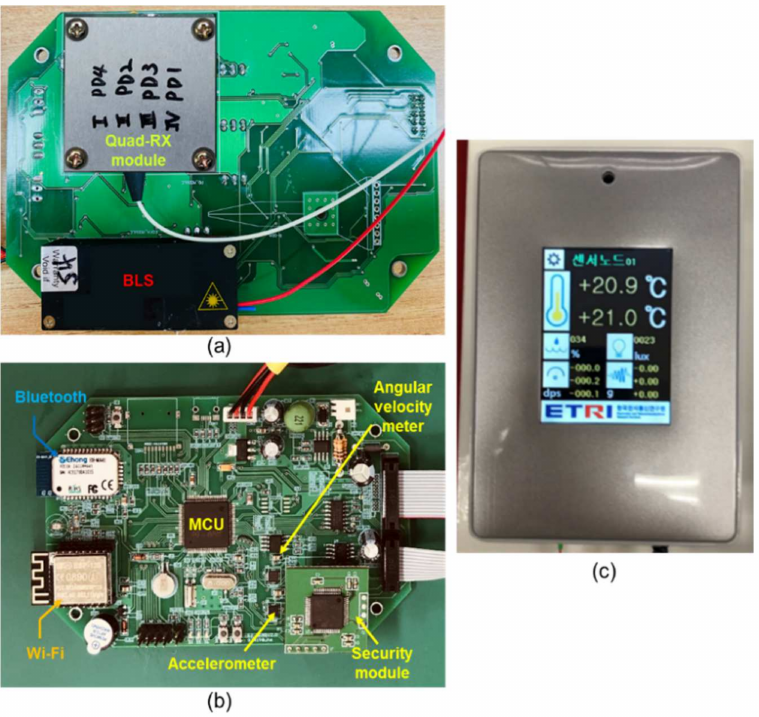
Figure 6. Photographs of the ( a ) top-view of the first layer, ( b ) top-view of the second layer, and ( c ) the end